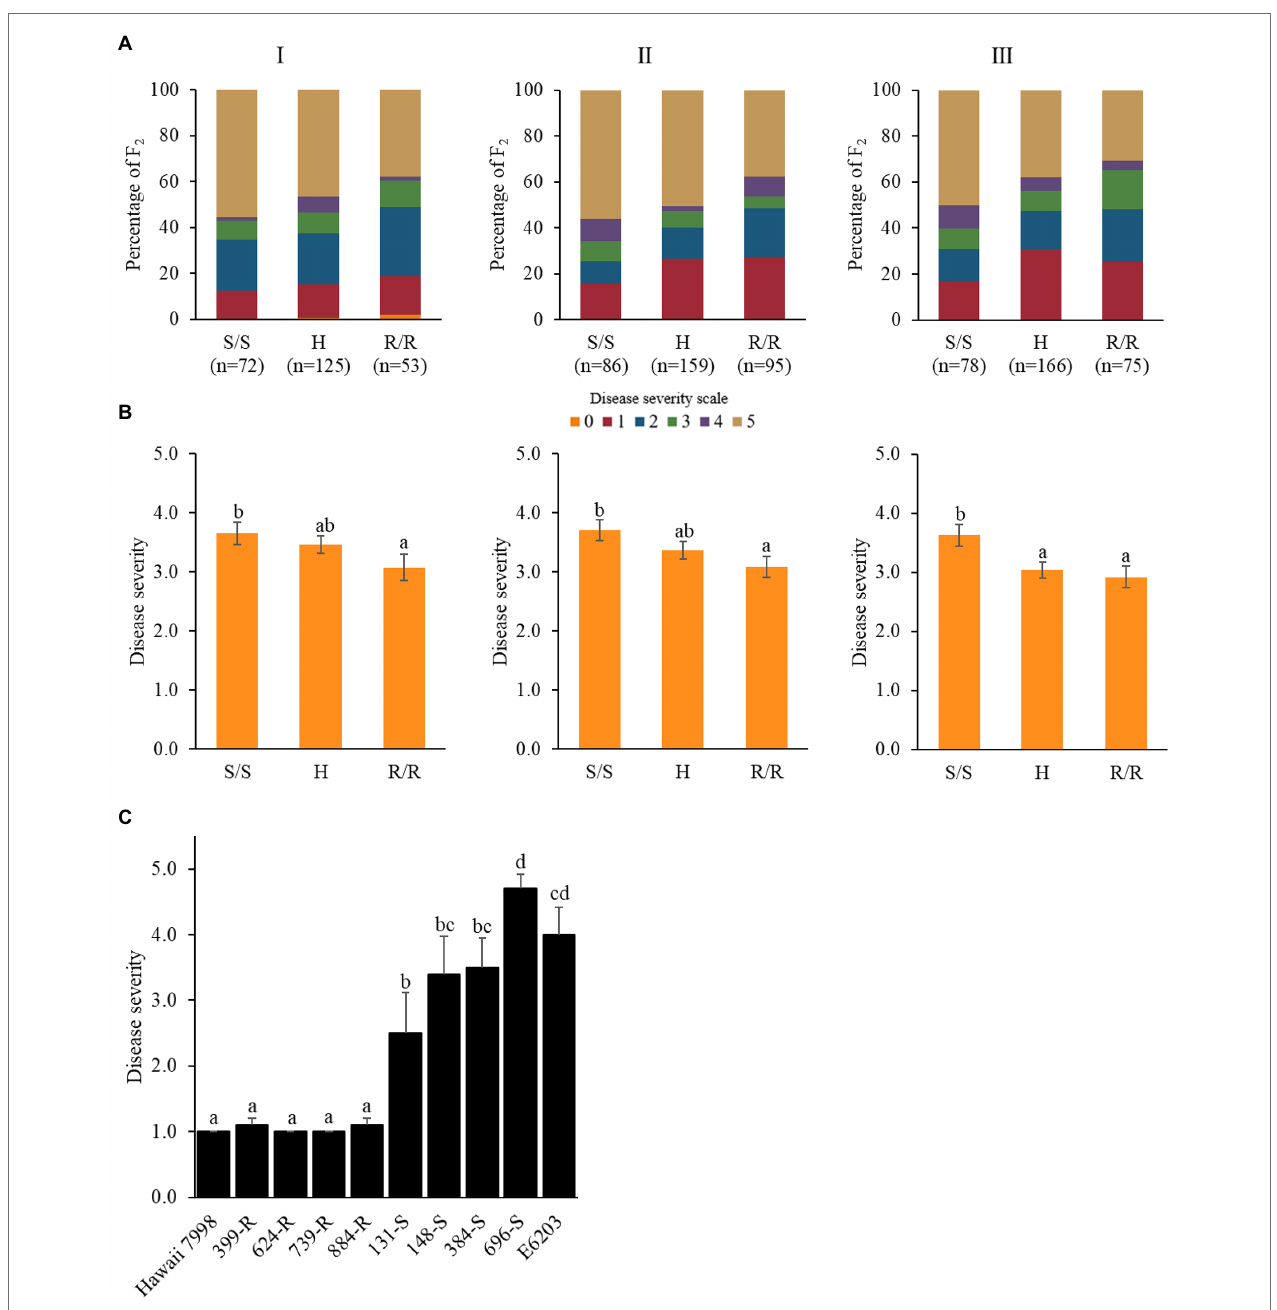
FIGURE 3 | Performance of Rcm6-9 in the F 2 population derived from “E6203” and “Hawaii 7998” in three experiments. (A) Percentage of F 2 with each disease scale within the genotypes. (B) Mean values with different letters on the bars are significantly different ( p < 0.05) according to Duncan’s multiple range test. S represents the susceptible “E6203” allele, H represents the heterozygote, and R represents the resistant “Hawaii 7998” allele. (C) Disease severity of the F 3 progenies harboring homozygous “Hawaii 7998” alleles (R) and homozygous “E6203” alleles (S) of Rcm6-9 at 5 weeks post-inoculation against Cm. Mean values with different letters on the bars are significantly different ( p < 0.05) according to Duncan’s multiple range